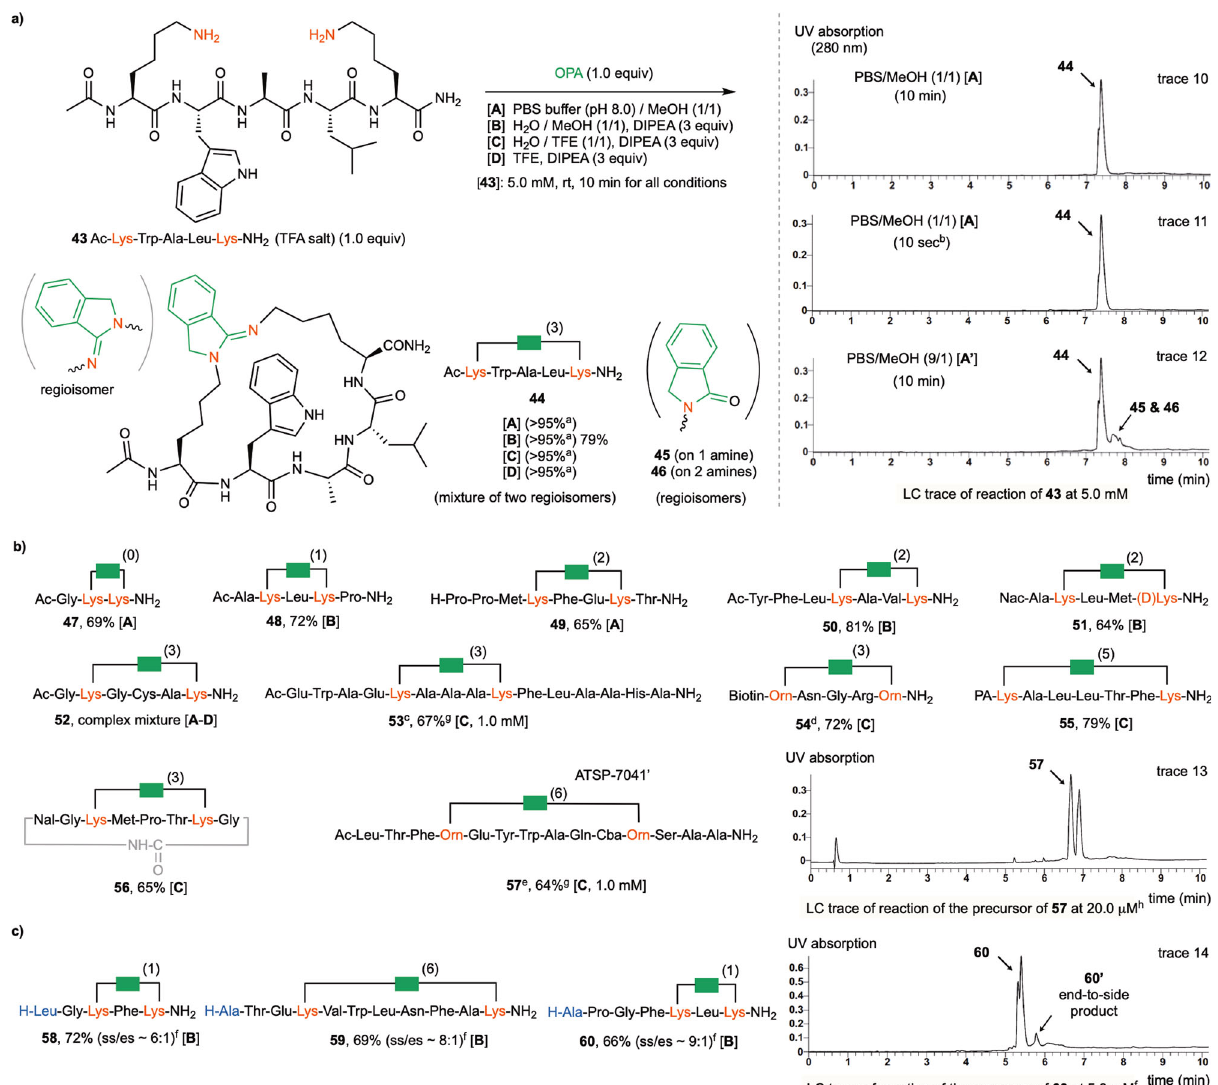
Fig. 4 OPA-2amines reaction for side-to-side stapling of peptides. a Model reaction of 43 . b In fl uence of spacing units and amino acid composition. c ) Reaction of substrates with free N-terminal NH 2 . Yield is based on HPLC isolated product of reactions conducted at 5.0 mM concentration and 0.01- 0.05 mmol scale unless otherwise speci fi ed. All products were obtained as a mixture of regioisomers. a LC-estimated yield. b A small aliquot of the reaction mixture was taken and quenched with mixed solvents of H 2 O/MeOH/HCO 2 H before subjection to LC-MS analysis. c Adaption from an α helical sequence of RNase A. d Biotin was attached to the N-terminus. e Adaption from peptide ATSP-7041. f The structures of the major side-to-side (ss) stapled products were con fi rmed by comparison with the samples prepared from properly protected substrates, see Supplementary Fig. 48 for details. The minor peaks were assigned as the end-to-side (es) products according to molecular weight and their structures have not been vigorously con fi rmed. The ss/es ratio was estimated by LC-MS analysis. g Reaction was conducted at 1.0 mM for 10 min. h Reaction was conducted at 20.0 μ M for 10 min. Nal: L-1-Naphthylalanine. PA: picolinic acid. The uncapped N-terminal AA units are marked in ocean blue, the lysine units and amino groups are marked in red, the OPA reagent and isoindolinimine core are marked in